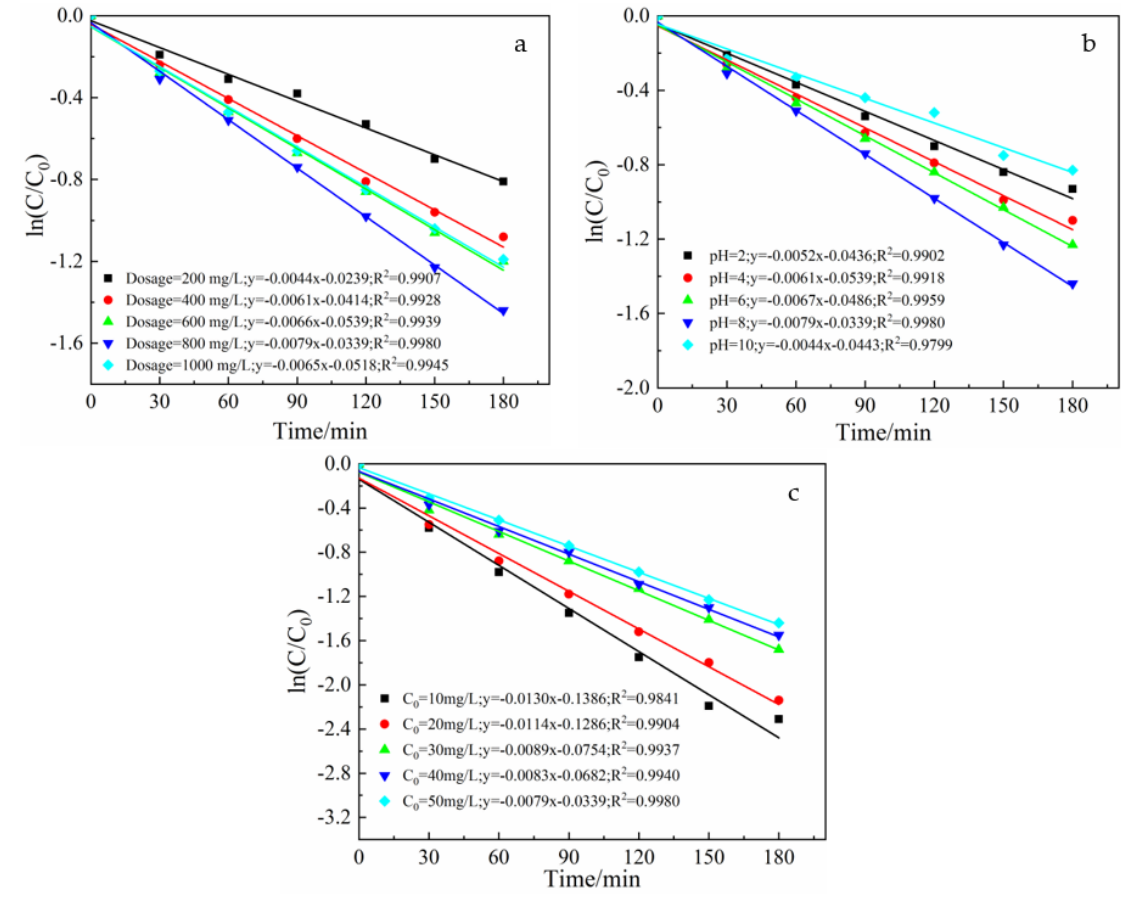
Figure 7. ln(C/C 0 ) − t relationship curve for different variables: ( a ) composite photocatalyst dosage, ( b ) different pH values and ( c ) different concentration.